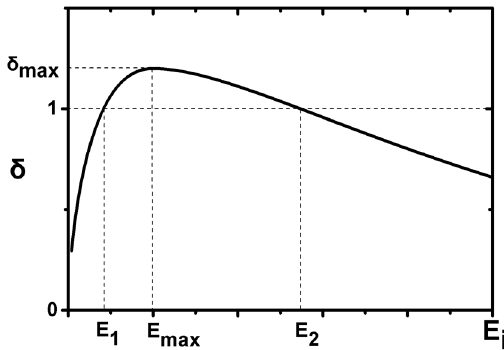
FIG. 26. Secondary electron yield as a function of the impact